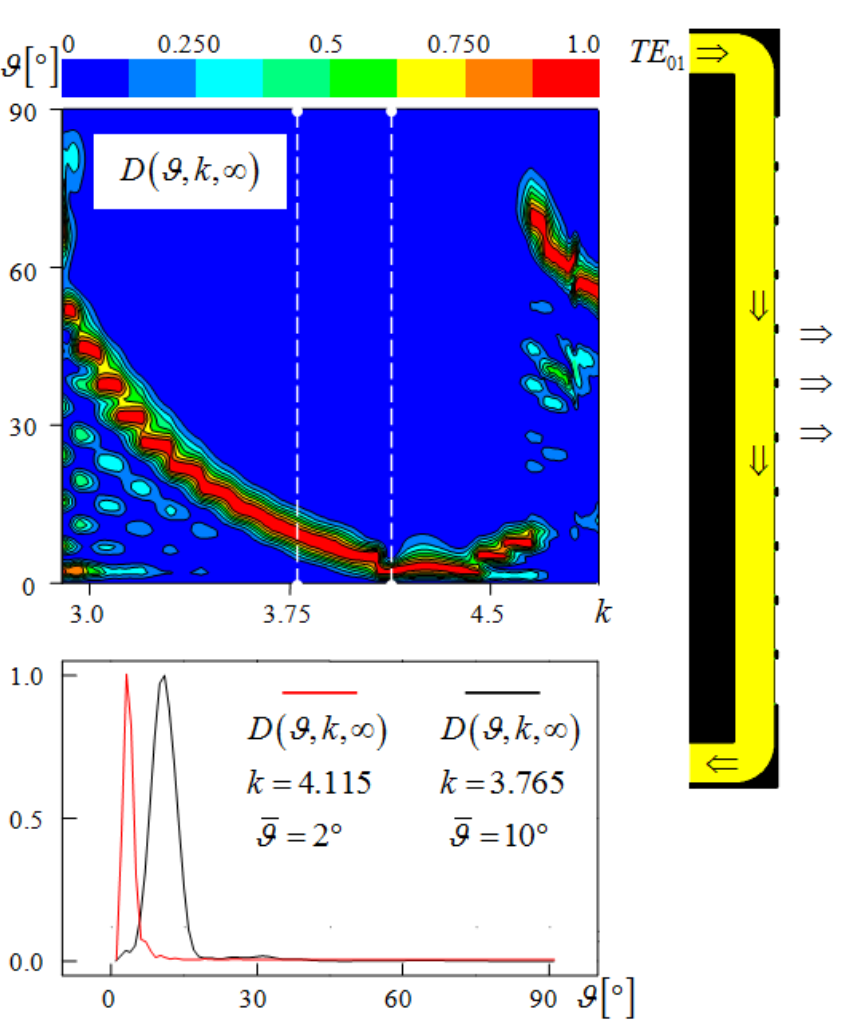
( ) , , D k ϑ ∞ of emitter in the frequency band 2.9 4.9 k ≤ ≤ and Figure 7. Radiation pattern D ( ϑ , k , ∞ ) of emitter in the frequency band 2.9 ≤ k ≤ 4.9 and at Figure 7. Radiation pattern frequencies k = k oper = 3.765 and k = k oper = 4.115 ( f oper ≈ 0.18 GHz and f oper ≈ 0.196 GHz). = = at frequencies oper 3.765 k k and oper 4.115 k oper and 0.196 f GHz ≈ ). oper